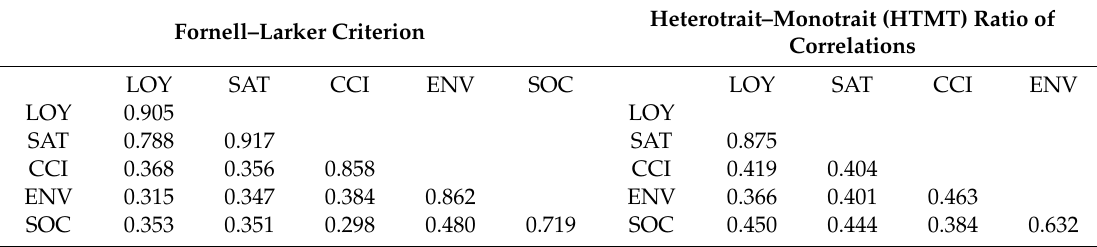
Table 5. Discriminant validity assessment.